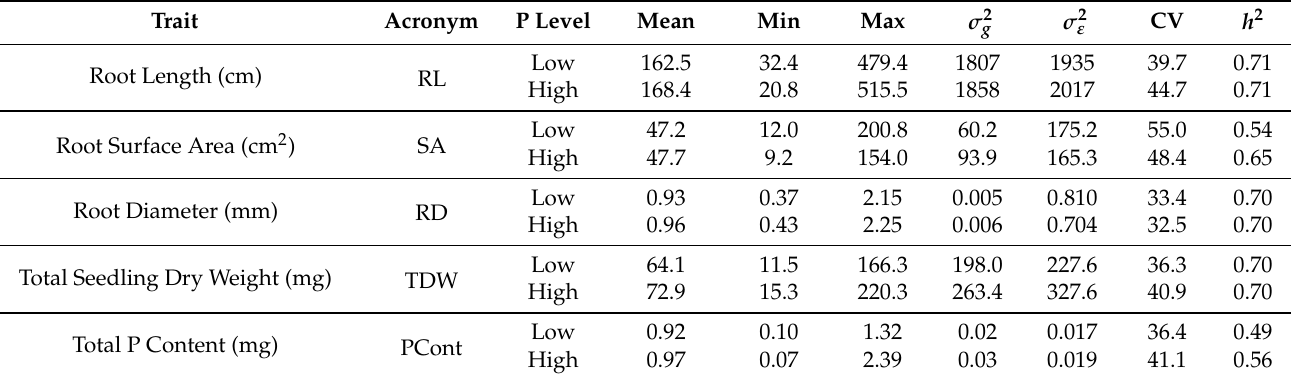
Table 1. Phenotypic mean, minimum (Min) and maximum (Max) values, genetic ( σ 2 g ) and residual ( σ 2 ε ) variances, coefficient of variation (CV, %) and broad-sense heritability ( h 2 ) of the five traits evaluated under low- and high-phosphorus (P) levels in 561 tropical maize lines.